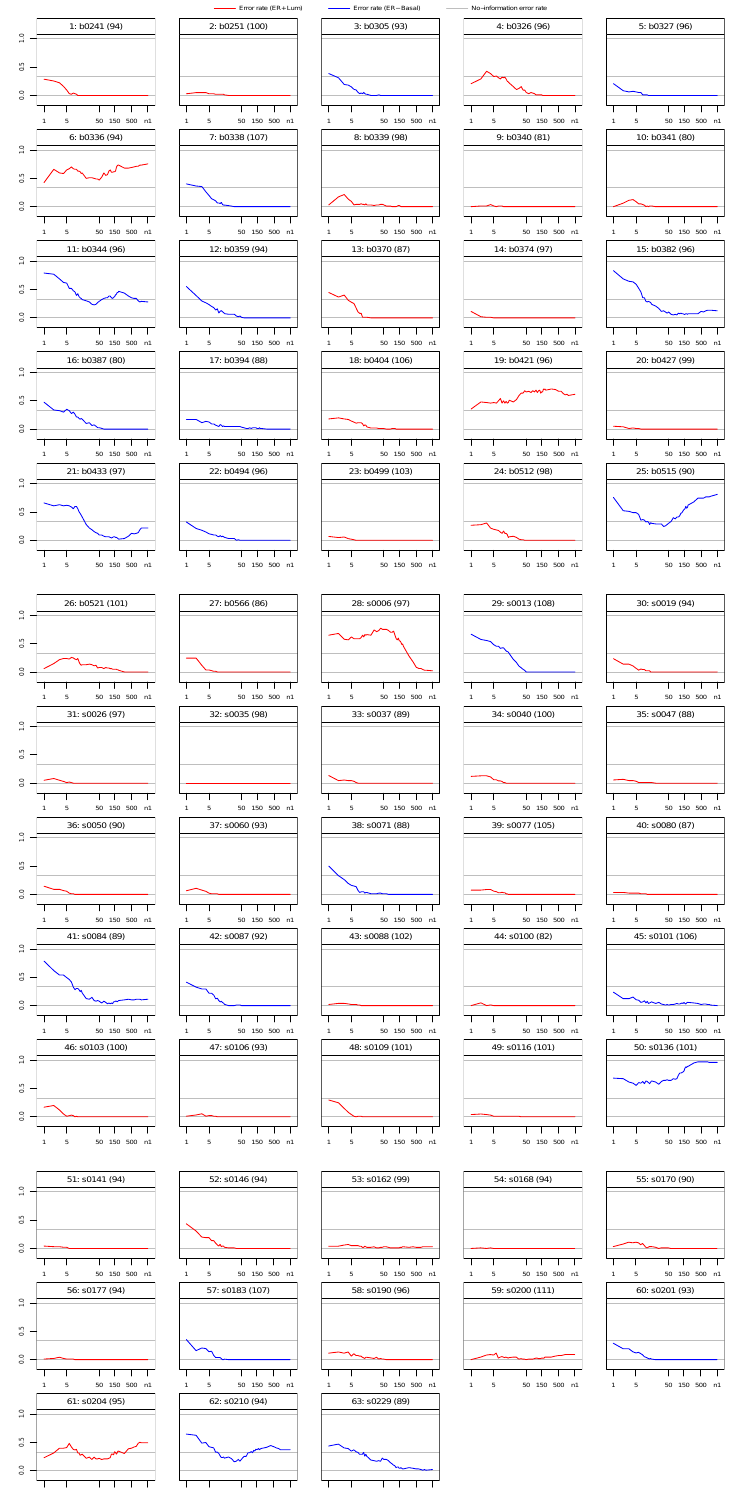
Figure 4: Sample-tracking error analysis of Lum/ER+ and Basal/ER- task on the copy number data (BAC features). For each sample, the plot indicates percent error for BioDCV runs (indicated in parenthes) in which the sample is in test, averaged on models of the same feature set size. The horizontal grey line indicates the no-information error rate for baseline